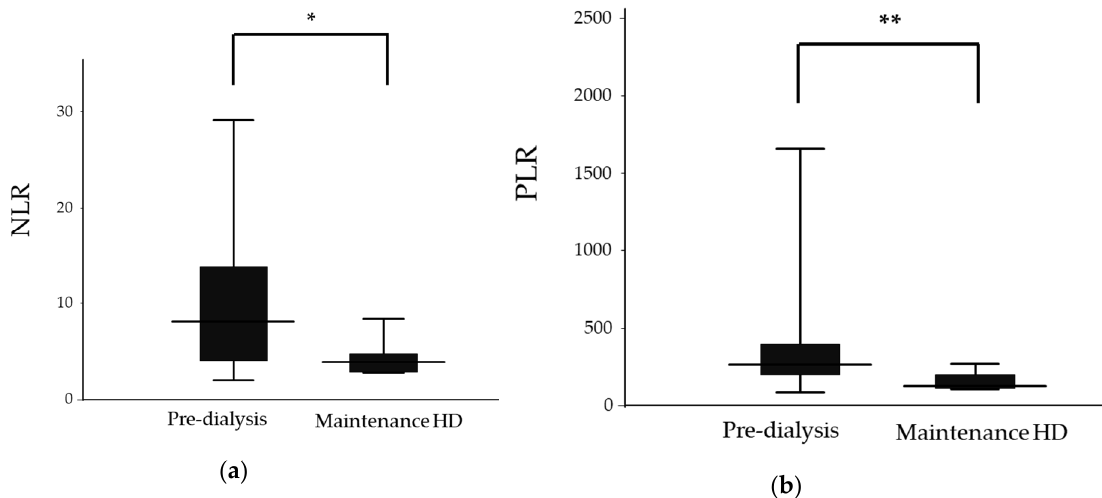
Figure 2. Neutrophil-to-lymphocyte ratios (NLR) and platelet-to-lymphocyte ratios (PLR) in the pre-dialysis and maintenance hemodialysis (HD) groups. ( a ) NLR in the pre-dialysis and maintenance HD groups. ( b ) PLR in the pre-dialysis and maintenance HD groups. The top and the bottom of the boxes are the first and third quartile, respectively. The length of the box represents the interquartile range. The line through the middle of each box represents the median. The error bars show the minimum and maximum values (range). *, p < 0.05; ** p < 0.01. NLR—neutrophil-to-lymphocyte ratio; PLR—platelet-to-lymphocyte ratio;